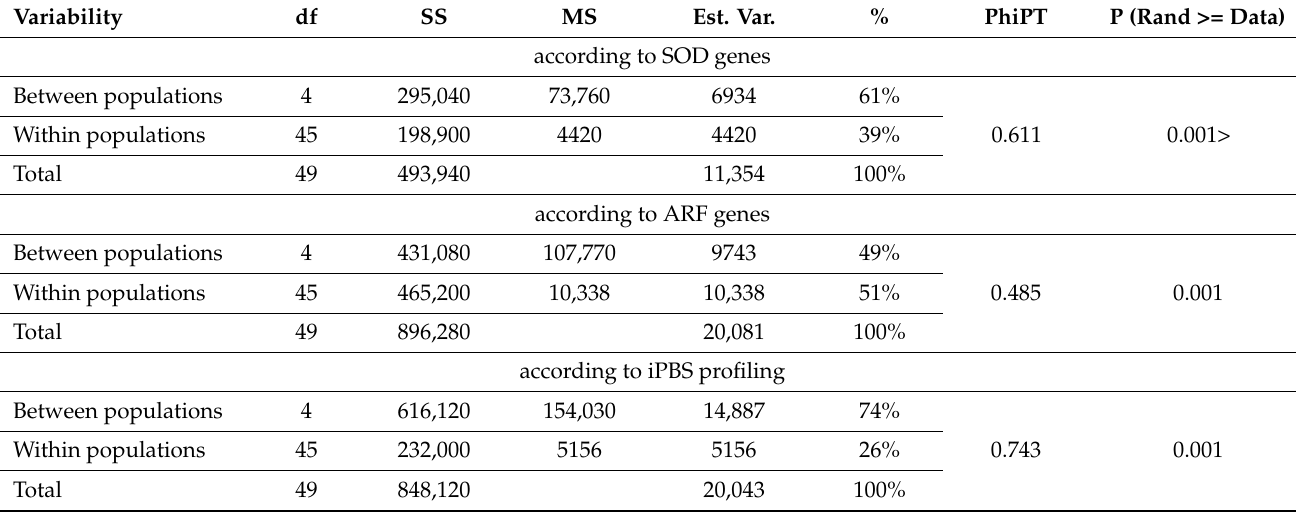
Table 2. Analysis of molecular variance of Rhodiola species .